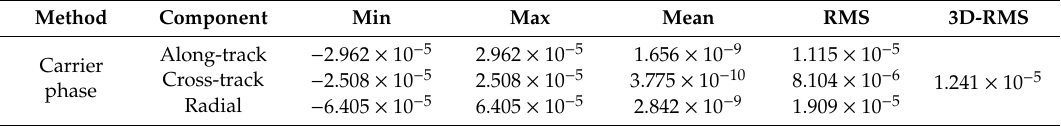
Table 4. Error statistics of the residual accelerations of 71 days (unit: m/s 2 ).